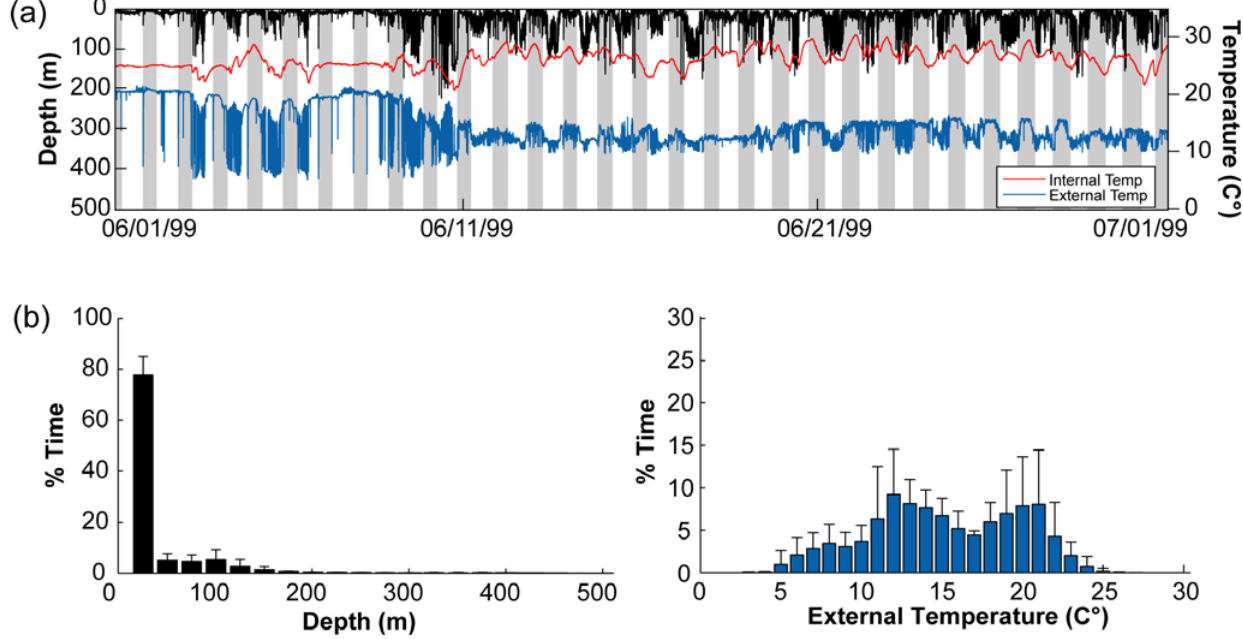
Figure 8. Typical diving behavior, external and internal temperature in the high use area of New England. (a) One month of a typical diving behavior (black) profile displayed with external (blue) and internal temperature (red) (WC98-521). Grey shaded region indicates nighttime obtained through light level data . (b) Overall yearly depth (left, black histogram) and ambient temperature (right, blue histogram) preferences in the high use area of the Northwest Atlantic (1997–2005, n=26).